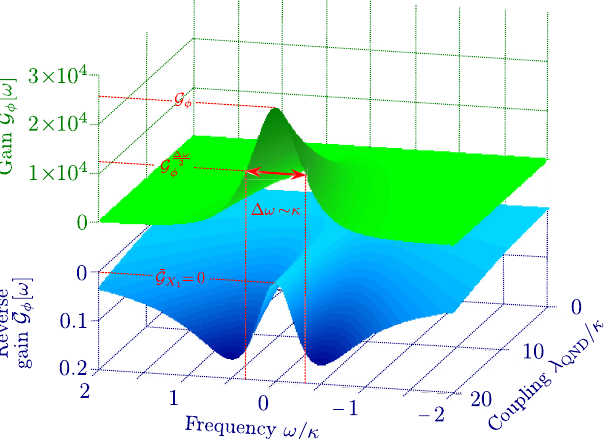
¯ G ω (cid:2) of the directional FIG. 5. Gain G ϕ ½ ω (cid:2) and reverse gain ϕ ½ phase-sensitive amplifier, plotted as a function of signal fre- quency ω and coherent coupling strength λ [cf. Eq. (25)], QND assuming that the dissipative coupling Γ always satisfies the matching condition Γ ¼ λ [cf. Eq. (28)]. G ϕ ½ ω (cid:2) describes the QND amplification in transmission of signals incident on the cavity-1 P ¯ G ω (cid:2) describes the amplification in trans- quadrature, while ϕ ½ mission of signals incident on the cavity-2 X quadrature. We have taken the engineered reservoir to be an auxiliary cavity mode with damping rate κ 0 = κ ¼ 100 (see Sec. III C). In this limit, deviations from the Markovian-reservoir approximation are